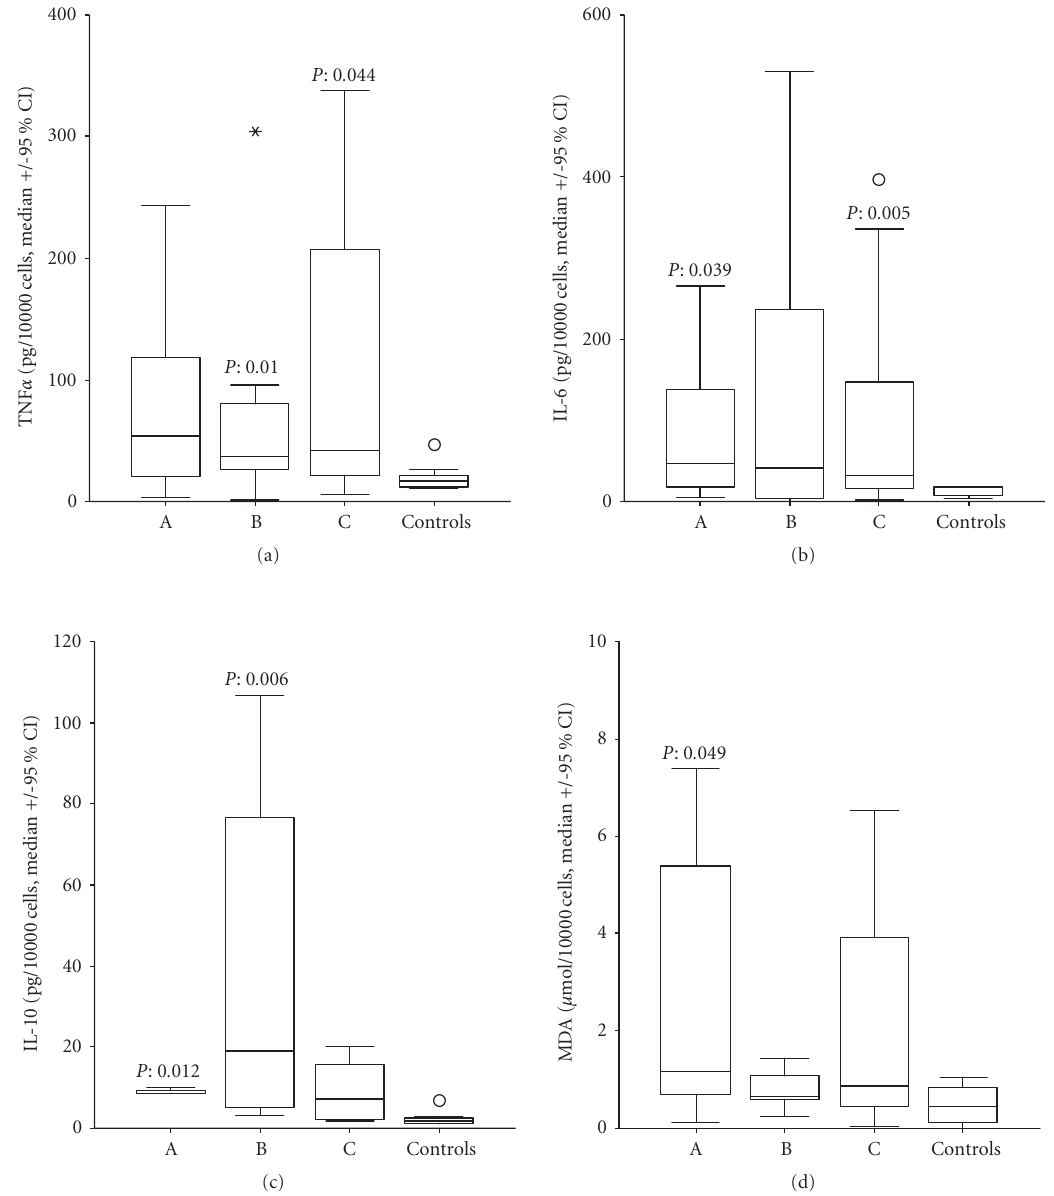
Figure 1: Ex vivo release of tumour necrosis factor-alpha (TNF α ), IL-6, IL-10, and malondialdehyde (MDA) by monocytes of 51 patients with septic syndrome and nine healthy donors. Patients were divided into three groups depending on the time lapsing between blood sampling and advent of fever: group A: < 12 hours group B: 12–24 hours, and group C: > 24 hours. Asterisks denote outliers and circles denote extremes. P values refer to comparisons with